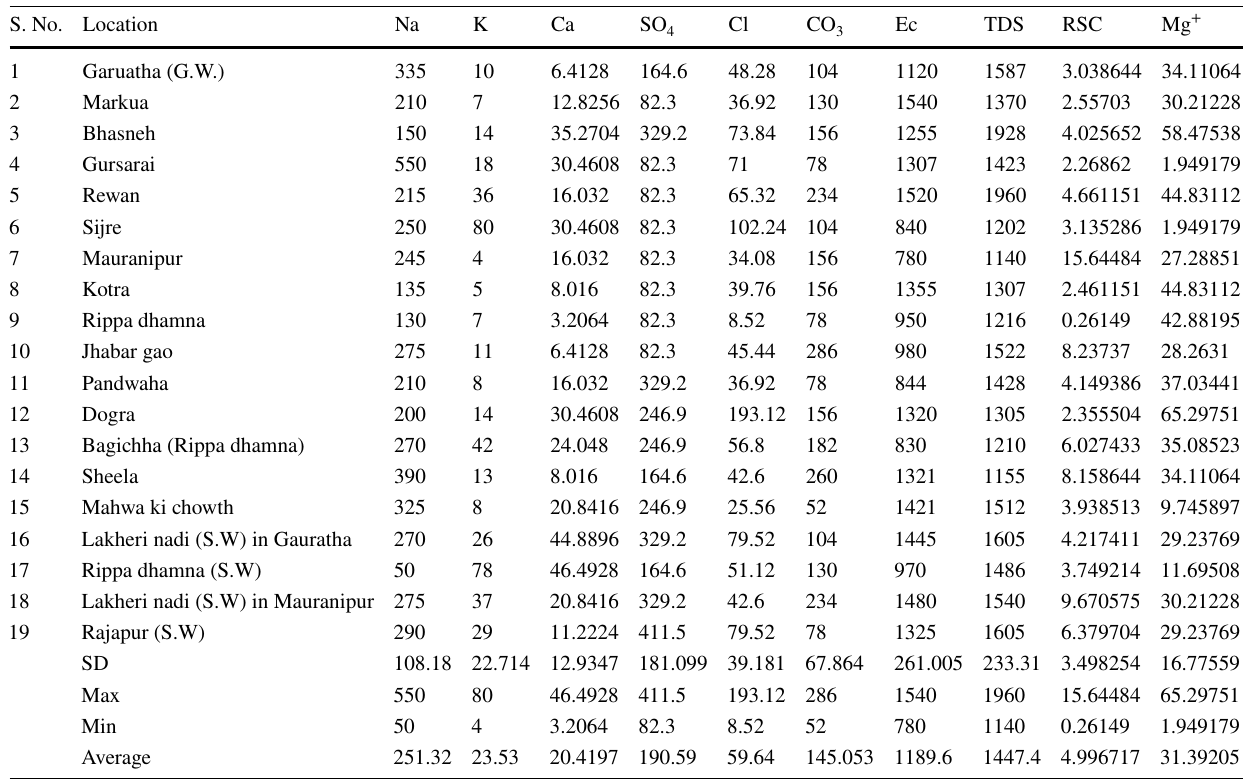
Table 1 Hydrochemical